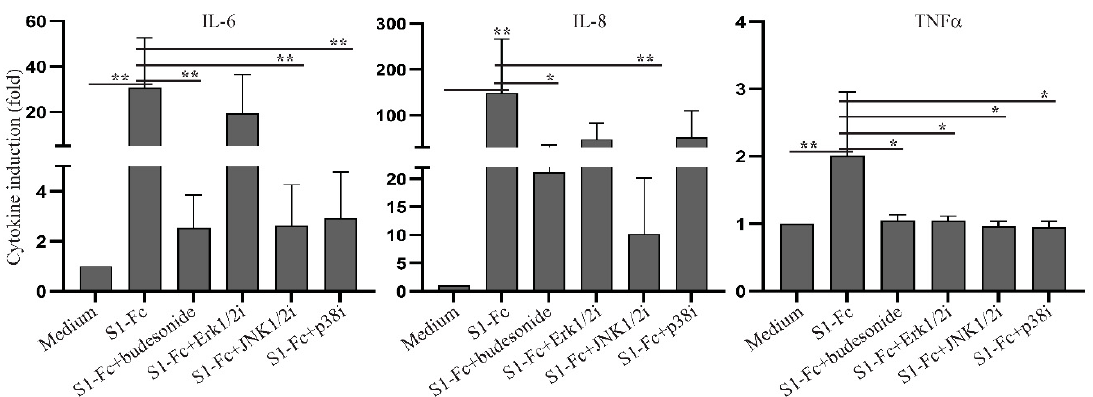
Figure 3. Inhibition of S1-Fc-induced cytokine responses by budesonide and MAPK inhibitors. Rested PBMC were cultured with or without 2.0 µg/mL of S1-Fc from Vendor #2 in the presence or absence of budesonide, U0126 (MEK1/2 inhibitor, Erk1/2i), SP600125 (JNK1/2 inhibitor, JNK1/2i) or SB203580 (p38 inhibitor, p38i) for 24 h. The levels of IL-6, TNF α and IL-8 were measured as described in Figure 2. Data shown are mean cytokine induction indices (fold) ± SE derived from 8 healthy donors, which were calculated using cytokine concentrations measured by the CBA assay (IL-6 and TNF α ) or the ELISA (IL-8) and the formula: cytokine concentration of treated PBMC/cytokine concentration of untreated PBMC. Statistical analyses were performed using a two-tailed, Student’s t -test. * and ** depict p < 0.05 and 0.01, respectively.